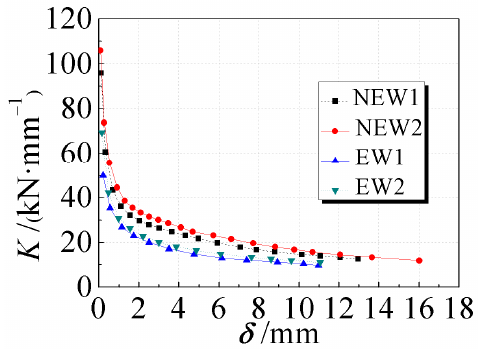
Figure 10. Stiffness degradation curves of